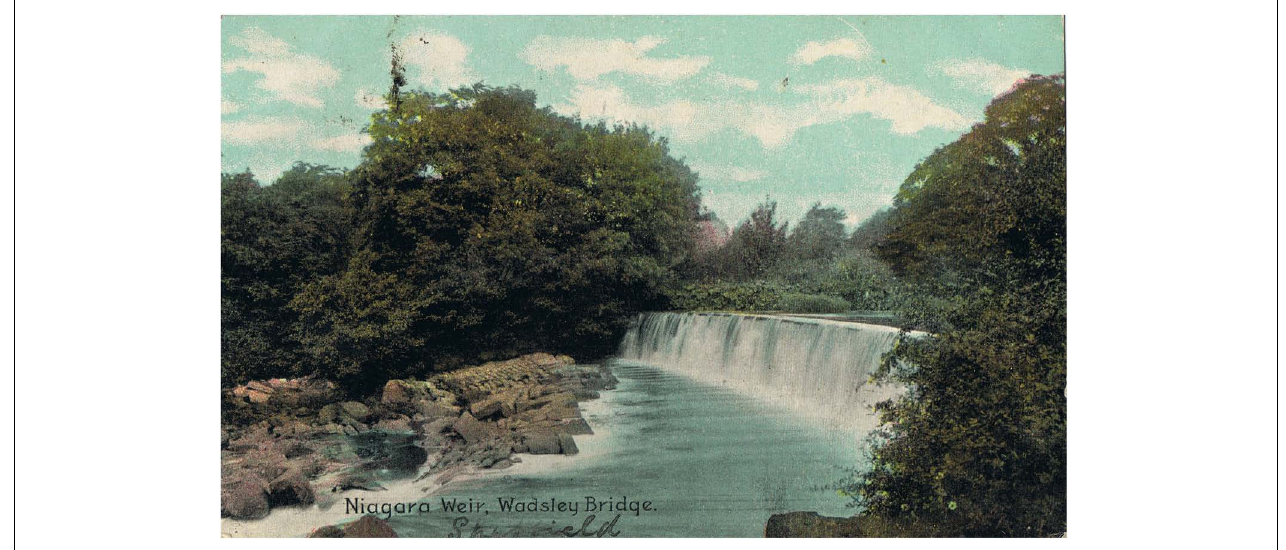
FIGURE 3 | Niagara Weir at Wadsley Bridge in the early 1900s and showing a good stand of the native riverside herb, butterbur ( Petasites hybridus